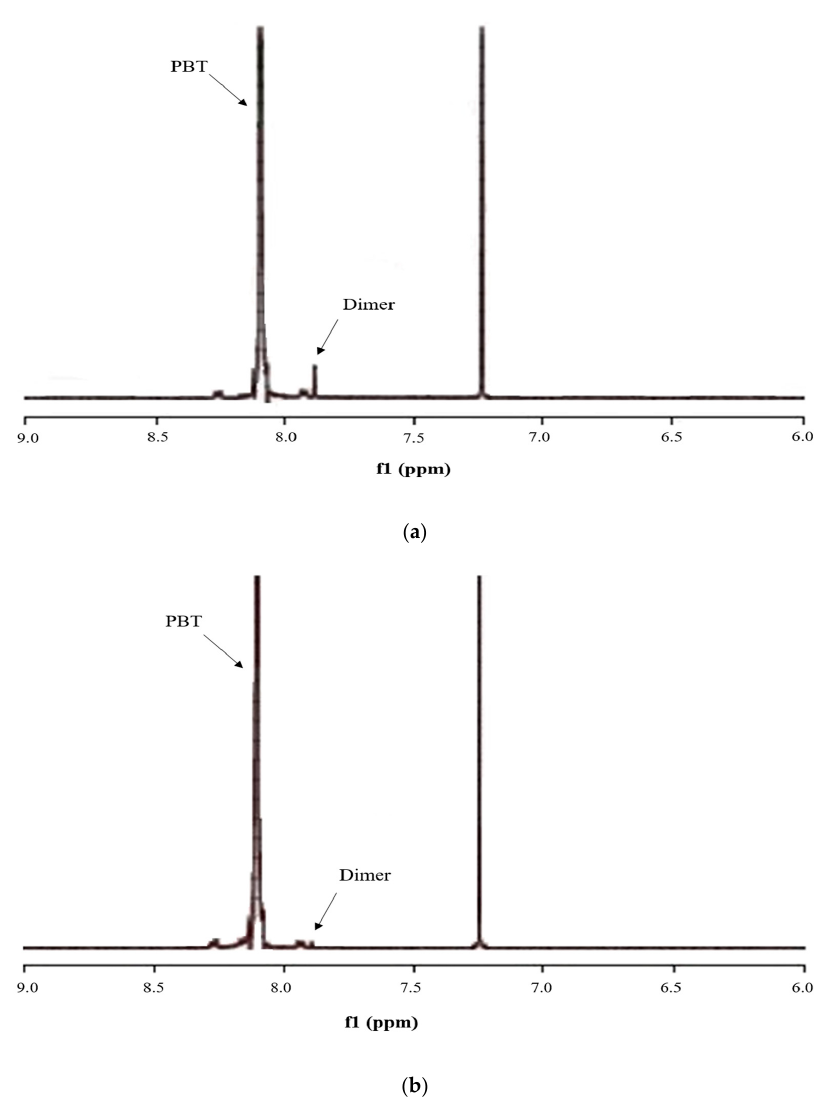
Figure 2. 1 H-NMR spectra of ( a ) initial PBT and ( b ) that collected after extraction by HFIP containing compressed CO 2